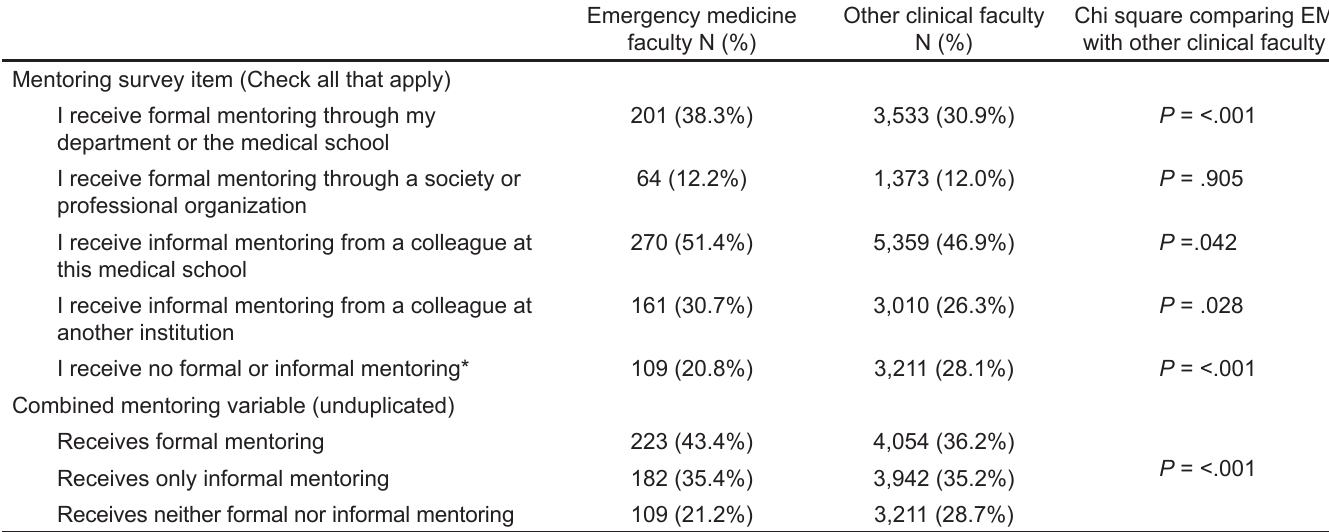
Table 2. Faculty mentoring